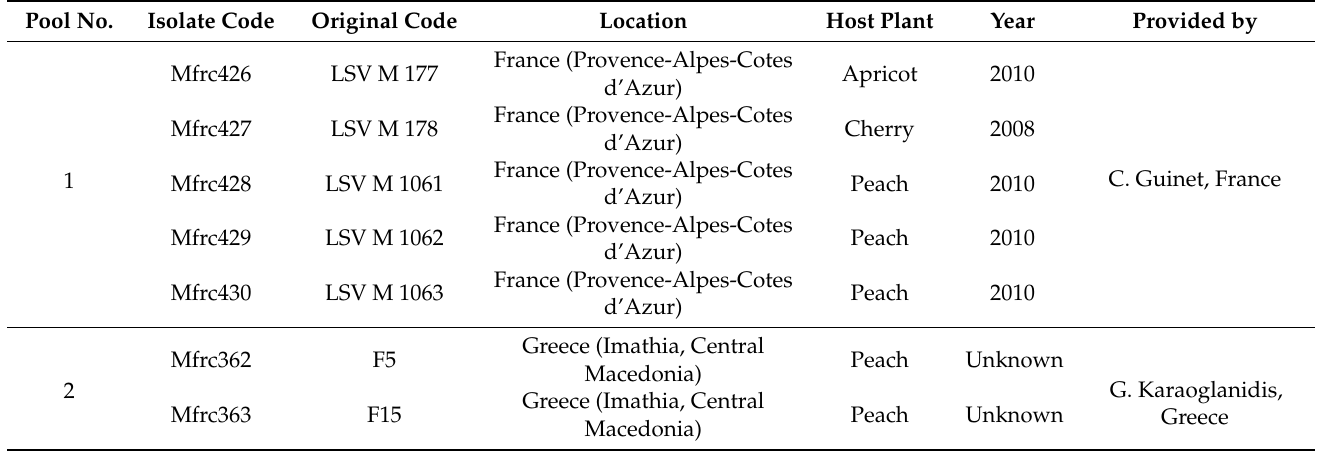
Table 1. Pools of M. fructicola strains used in the mycovirome characterization. Pool